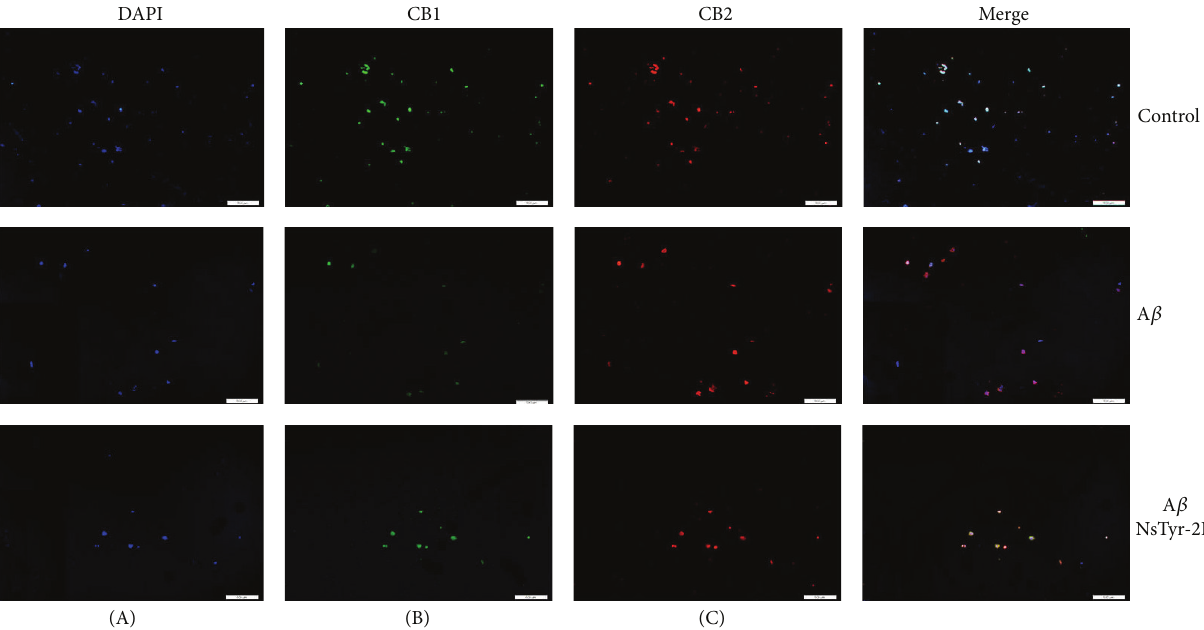
Figure5: Detection ofCB1and CB2receptor immunoreactivity inNSPCs. (A)NSPCswerecounterstained with DAPI (blue). (B)NSPCswere immunolabeled with anti-CB1 antibodies and AlexaFluor 488 goat anti-rabbit immunoglobulins (green). (C) NSPCs were immunolabeled with anti-CB2 antibodies and DyLight 694 goat anti-rabbit IgG (red) original magnification. (1) None, (2) 1 𝜇 M A 𝛽 1 1 𝜇 M NsTyr-2K,